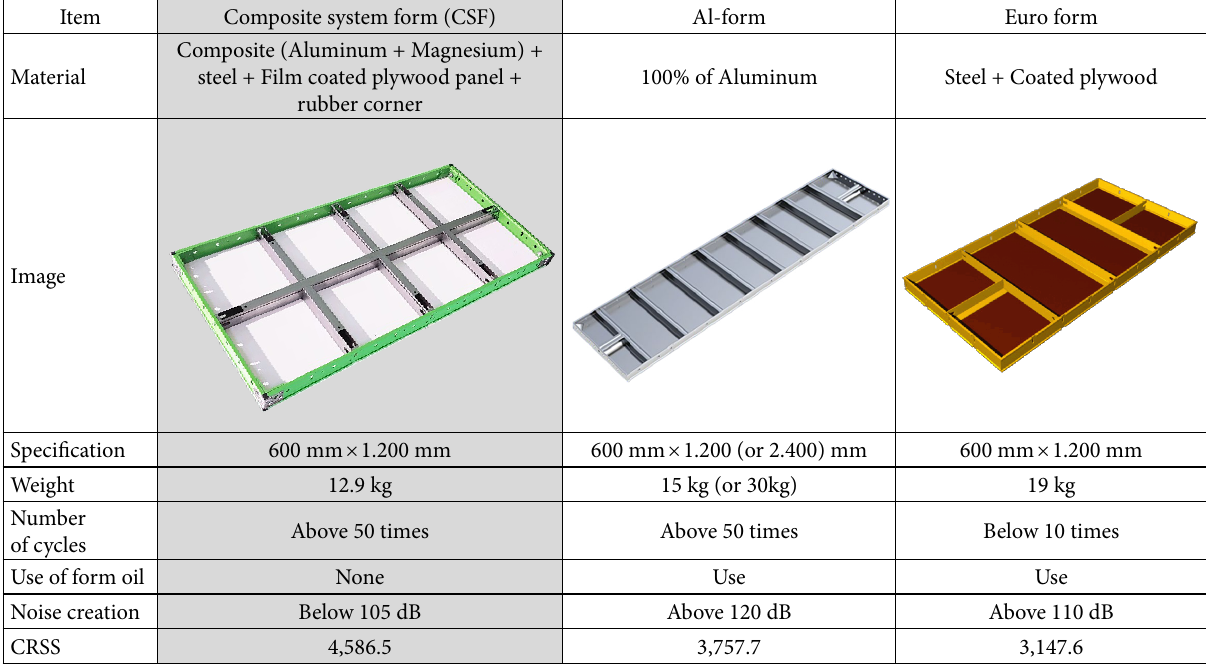
Table 11. Comparison between the CSF, Al-form, and Euro